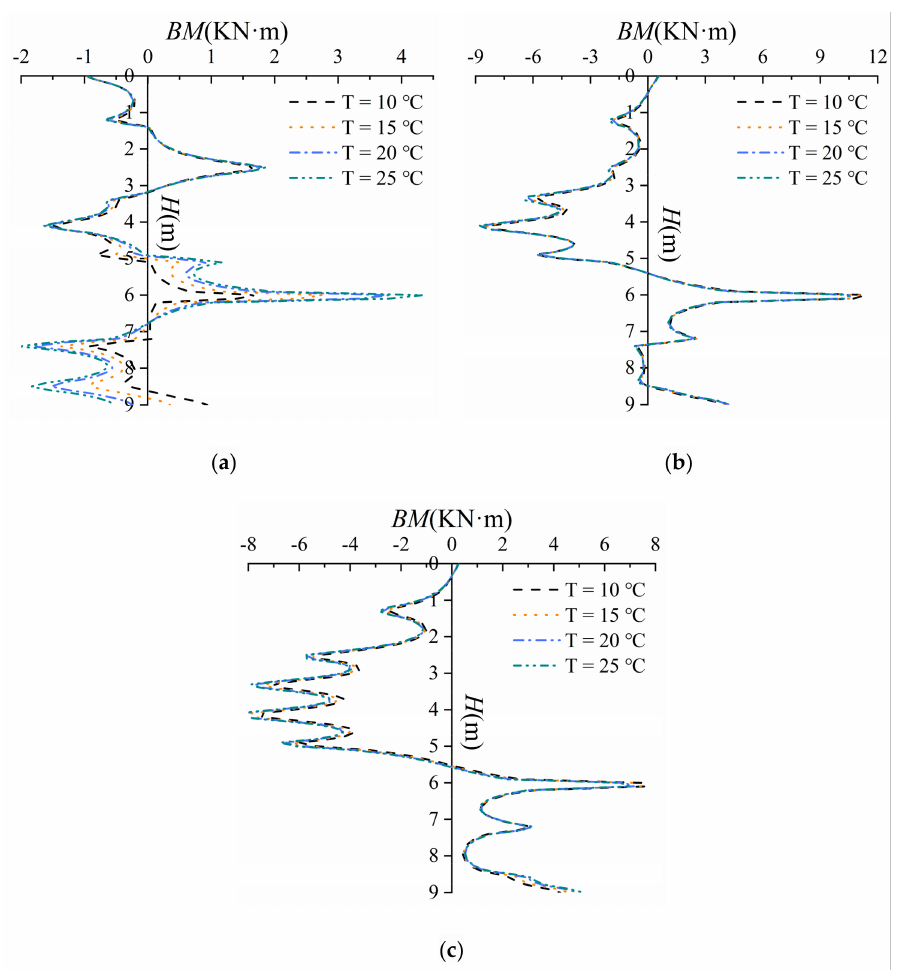
Figure 21. The bending moment ( BM )–temperature relationship of ( a ) pile 1, ( b ) pile 2, and ( c ) pile